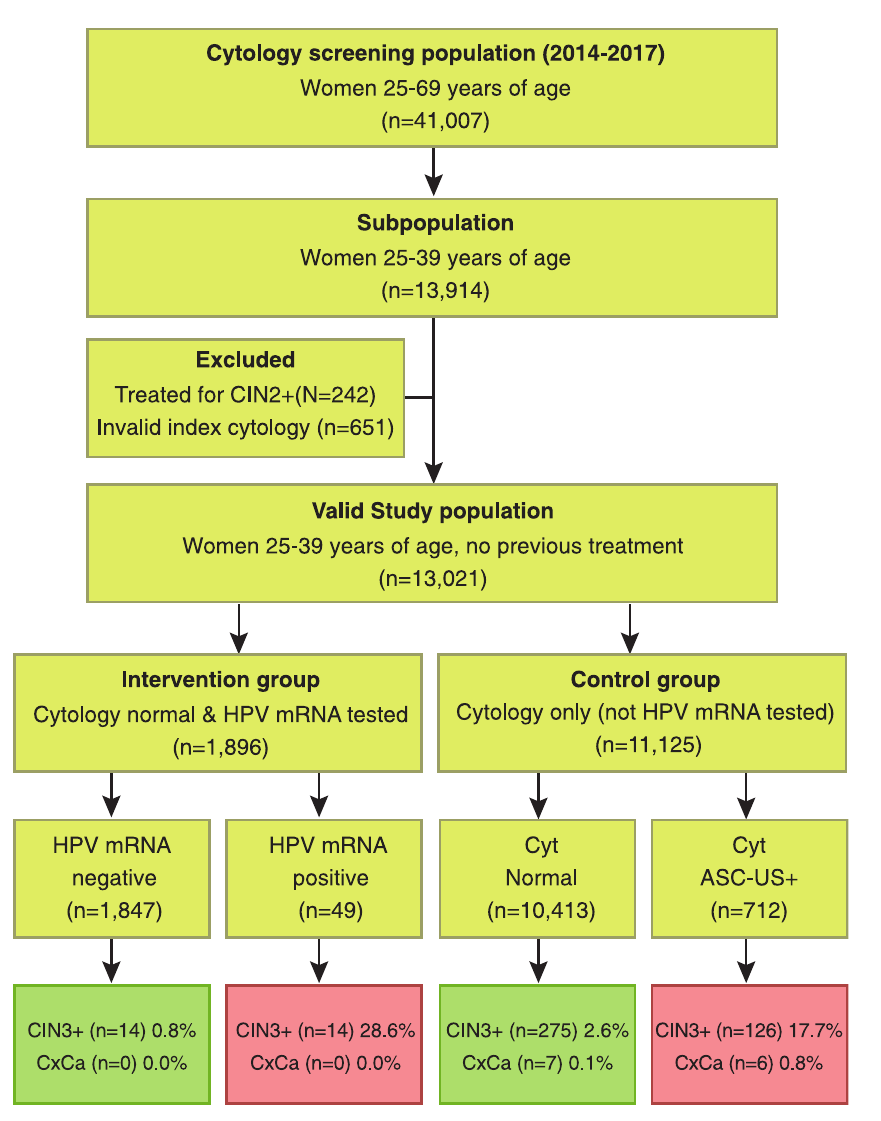
Fig 1. Study population by cytology (ASC-US+), HPV mRNA and histology (CIN3+) for 5–7 years follow-up. CIN2+ = cervical intraepithelial neoplasia grade 2 (CIN2), CIN3, ACIS and cervical cancer. CIN3+ = CIN3, ACIS and cervical cancer. ASC-US+ = abnormal cytology (ASC-US, LSIL, ASC-H, HSIL, ACIS and cervical cancer). CxCa = Cervical